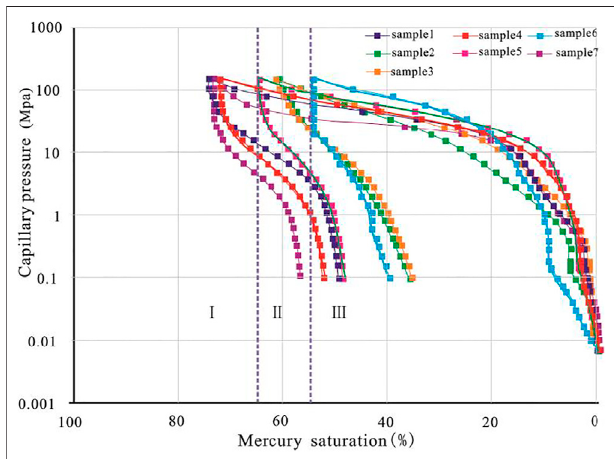
FIGURE8| Poretypes oftheMesozoicvolcanicreservoirintheDoil fi eld of the Laizhouwan sag.